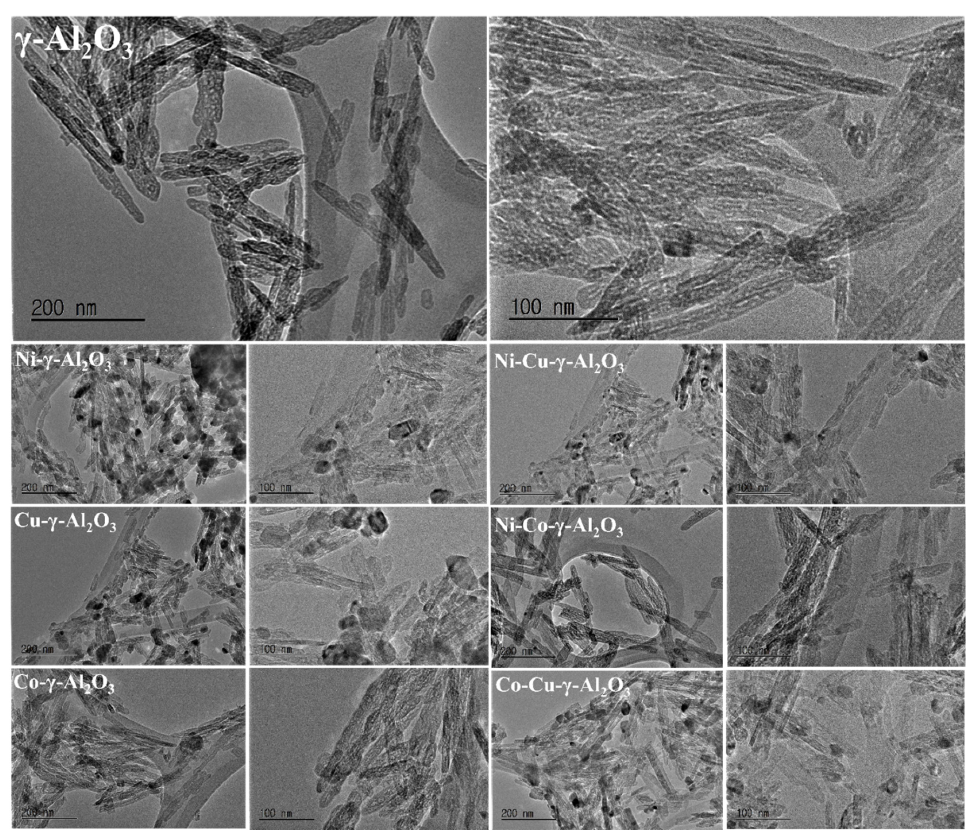
Figure 5. TEM images of monometallic and bimetallic catalysts.